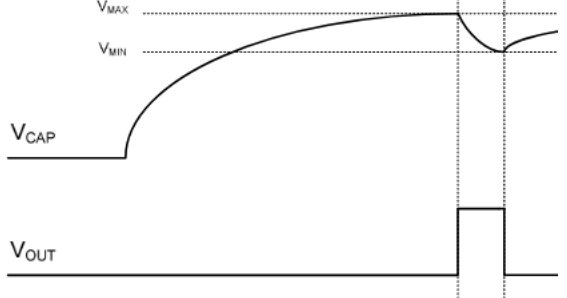
Figure 2. The timing diagram of capacitor charging. The sensor activates when the capacitor voltage reaches V max and keeps operating until the voltage drops to V min